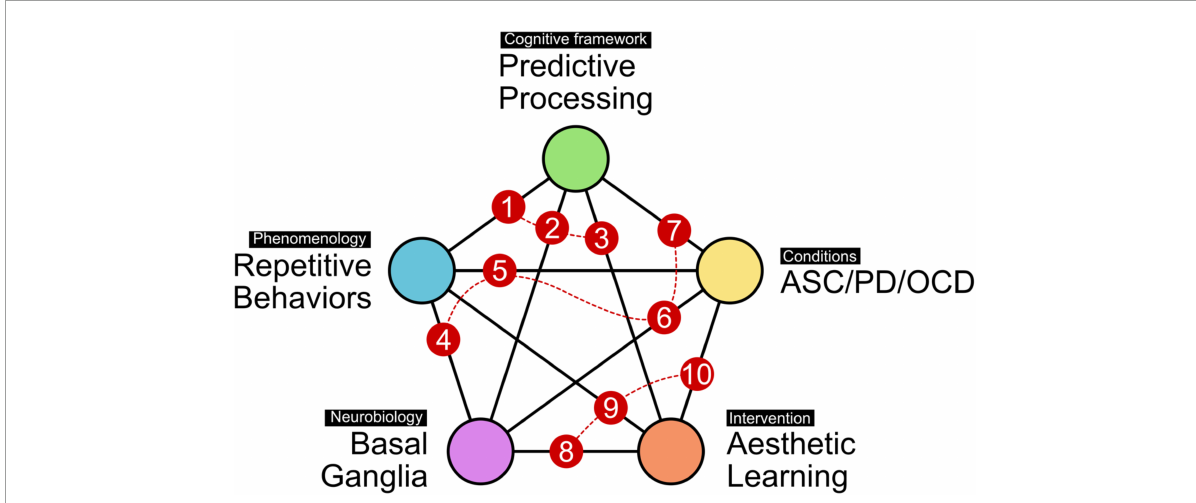
FIGURE1 Thematic landscape for approaching RSBs. The present paper assumes five interconnected themes of relevance. These include the phenomenology itself (i.e., observable behavior), the basal ganglia as a likely neuroanatomical and neurophysiological substrate, the cognitive framework of predictive processing as a high-level model of brain function, exemplary conditions selected for this discussion (ASC, PD, and OCD) which are partly characterized by RSBs, and lastly, how aesthetic learning emerges from, and interacts with, this thematic space. The numbering of pairwise connections provides a guide through the present paper. Sections “Repetitive stereotyped behavior and predictive processing (1), Predictive processing and basal ganglia (2), and Predictive processing and aesthetic learning (3)” will discuss how predictive processing relates to repetitive behaviors, neurobiology, and aesthetic learning. Sections “Repetitive behaviors and basal ganglia function (4), Repetitive phenomena in autism spectrum conditions, obsessive-compulsive disorder, and Parkinson’s disease (5), Basal ganglia involvement in autism spectrum conditions, obsessive-compulsive disorder, and Parkinson’s disease (6), and Predictive processing accounts of autism spectrum conditions, obsessive-compulsive disorder, and Parkinson’s disease (7)” will discuss the phenomenologies of the exemplary conditions, and how they relate to neurobiology and to the cognitive framework of predictive processing. Lastly, sections “Aesthetic learning and basal ganglia function (8), Aesthetic learning in repetitive stereotyped behaviors (9), and A role for aesthetic learning in autism spectrum conditions, obsessive-compulsive disorder, and Parkinson’s disease (10)” will focus on how basal ganglia circuits might influence aesthetic experience, and what this could mean for art and occupational therapies in conditions showing RSBs. Specifically, directing sensory salience through strategic contexts and learning environments may help to counterbalance skewed weighting of feedback signals by the basal ganglia, providing individual space for action, experience, and communication. Suggested key literature on all pair-wise connections: [1] (Perrykkad